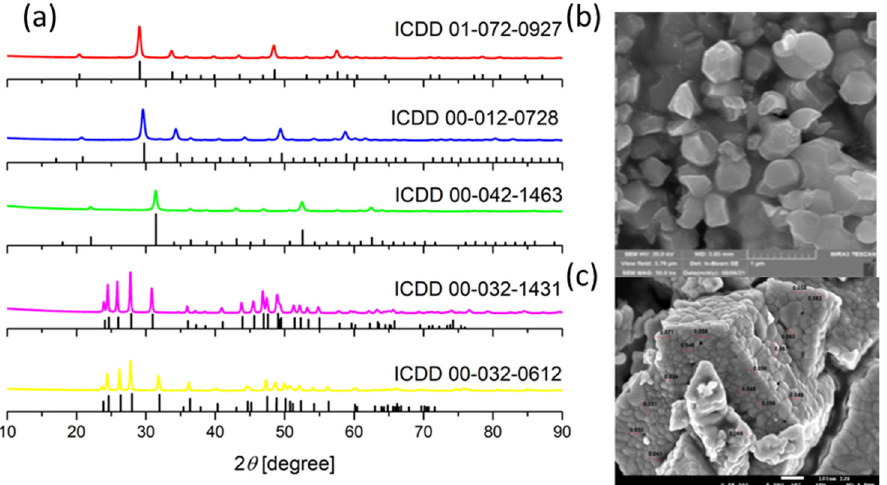
Figure 1. ( a ) XRD patterns of 3%Nd:Y 2 O 3 , 3%Nd:Lu 2 O 3 , 3%Nd:Sc 2 O 3 , 5%Nd:YF 3 , and 5%Nd:LuF 3 (top to bottom) with respective ICDD data; ( b ) SEM image of 3%Nd:Y 2 O 3 ; ( c ) SEM image of 5%Nd:YF 3 .